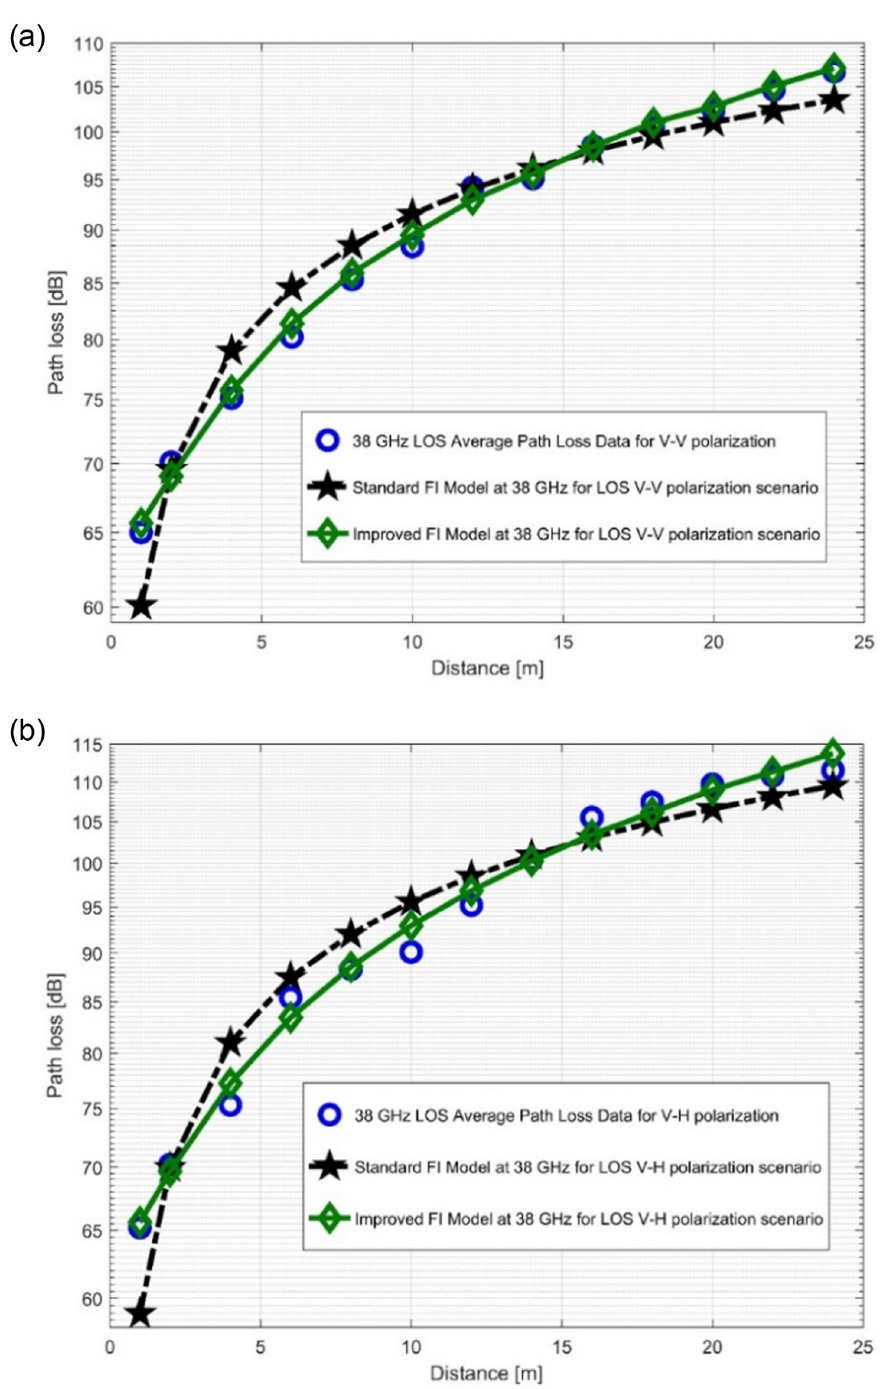
Fig 13. PL vs distance at 38 GHz for the LOS scenario at (a) V-V polarization, (b) V-H polarization.